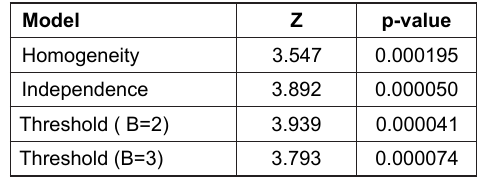
Table 24. Tests for randomness of collar distribu- tion for the Cape Bathurst 2005 survey.